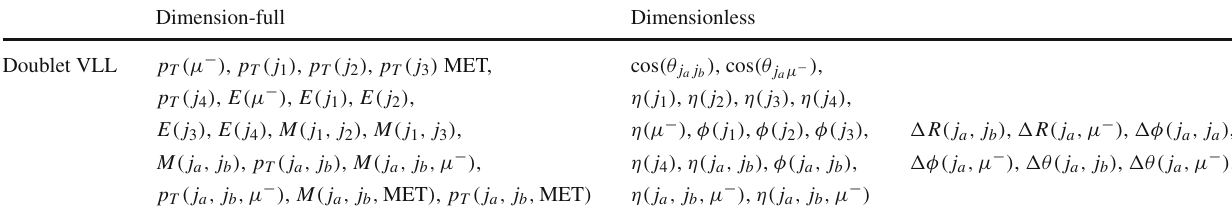
Table 4 Angular and kinematic distributions for the analysis of the doublet production topology. All observables are computed in the lab- oratory frame of reference. To simplify notation, we define ( j a , j b ) as